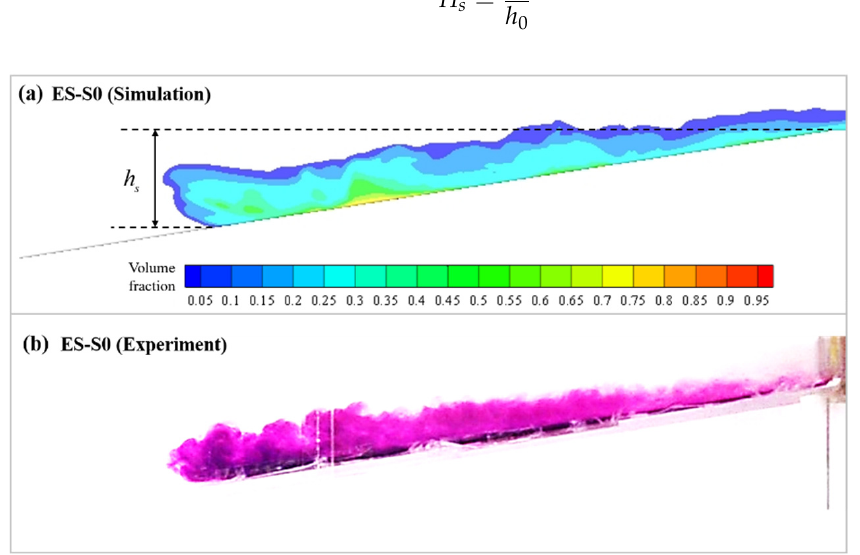
Figure 11. The separation depth of gravity current (Run ES-S0): ( a ) simulation; ( b ) experiment.